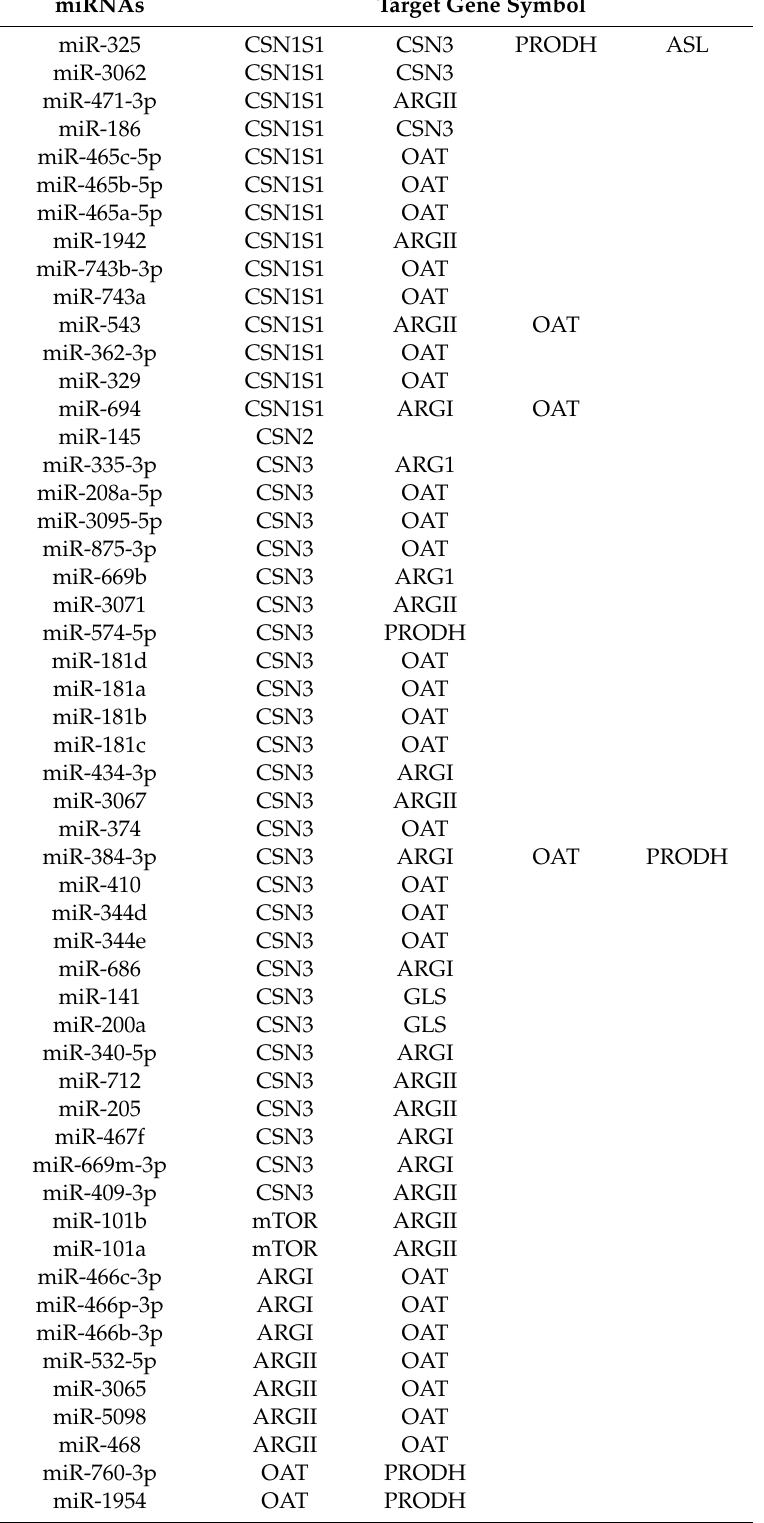
Table 2. Candidate miRNA in various genes related to casein protein yield in dairy